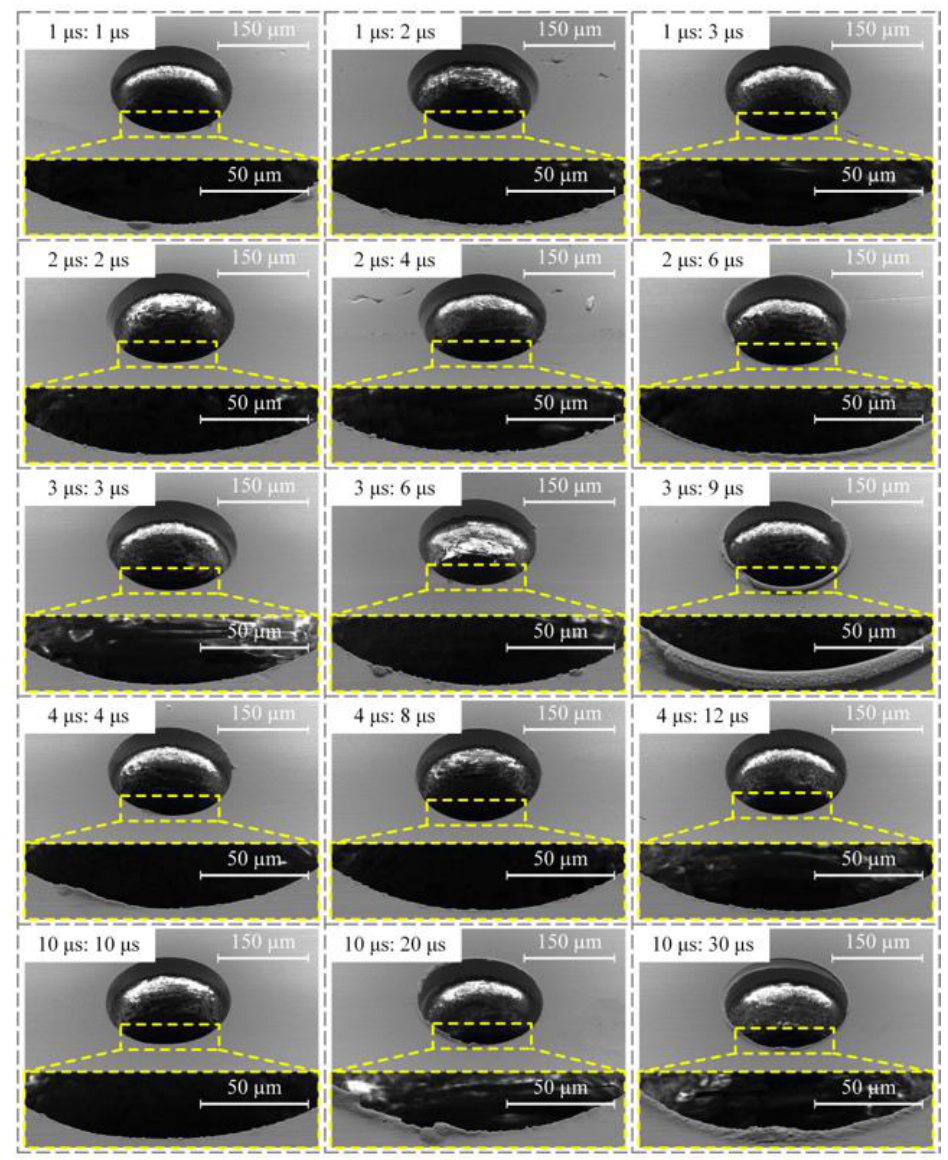
Figure 8. Influence of pulse width and duty cycle on the machining quality of micro-hole.